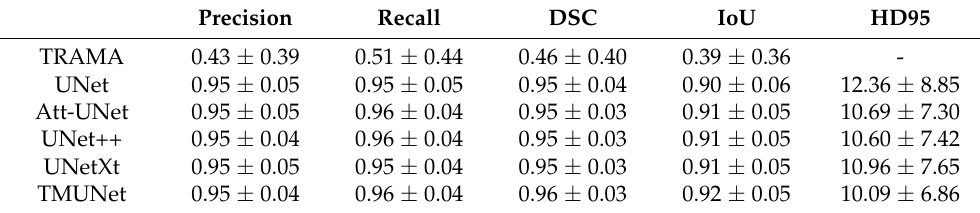
Table 2. Overall segmentation results for each segmentation model. The results are reported in mean ± std.